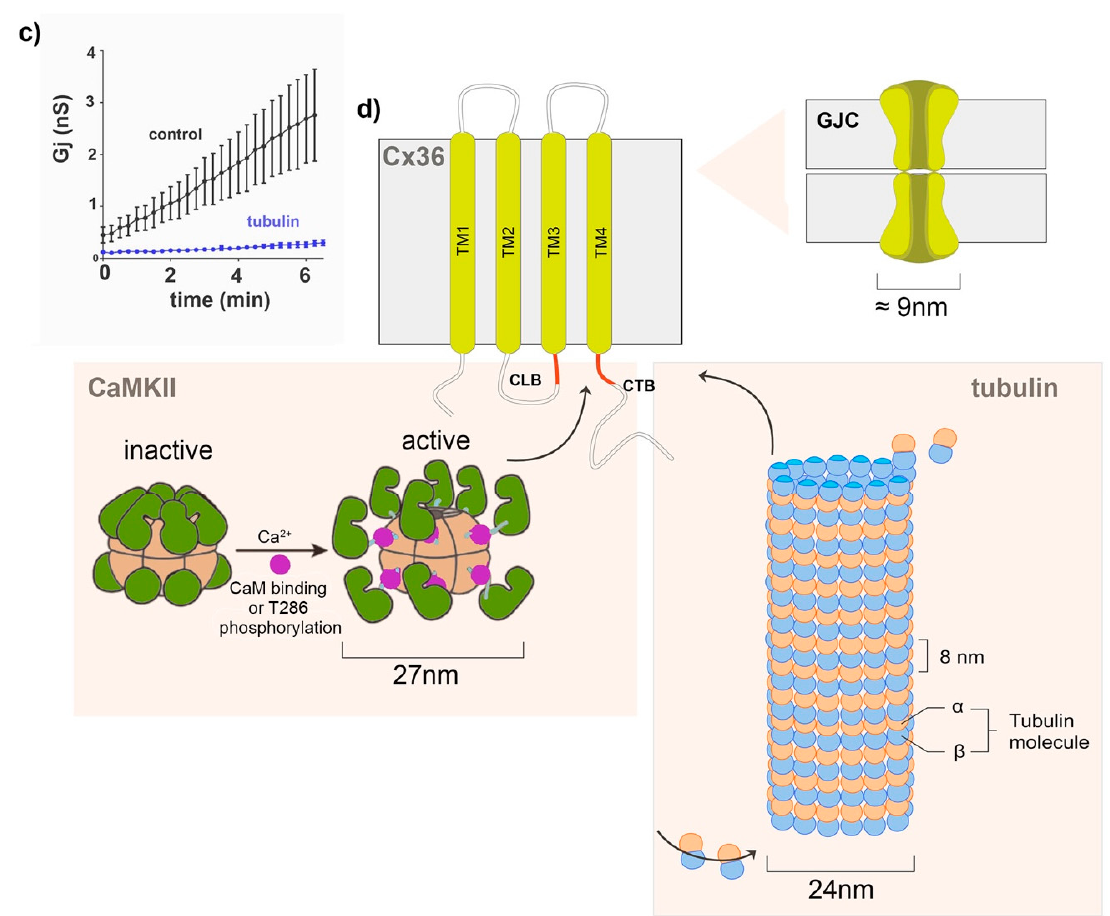
Figure 4. Cx36 interactions with macromolecular protein complexes. ( a – c ) Dual patch–clamp recordings of Neuro2a cell pairs expressing Cx36 typically reveal an initial 5–10-fold increase in the junctional conductance (Gj), termed run-up (black symbols), modified from reference [52]. The extent of the run-up was reduced by the intracellular application of peptides (100 µM) blocking the CLB (aa175–195) and CTB (aa272–292) sites of Cx36 (curves with red symbols). ( c ) The intracellular application of monomeric tubulin (50 µM) reduced the run-up plasticity (blue trace). Modified from reference [43]. ( d ) Summary of macromolecular interactions between Cx36 and the CaMKII holoenzyme or microtubules. As illustrated in Figure 3, CaMKII is activated by binding to the Ca 2+ /CaM complex or following T286 phosphorylation (modified from reference [85]. Active CaMKII binds to the intracellular CTB domain, a binding target shared with the CaM and microtubules. Details of the spatiotemporal regulation of how the macromolecular complexes bind are presently unknown; however, the linkage of Cx36 to microtubules likely facilitates its delivery to [87] the GJP, a function that is lost when microtubules